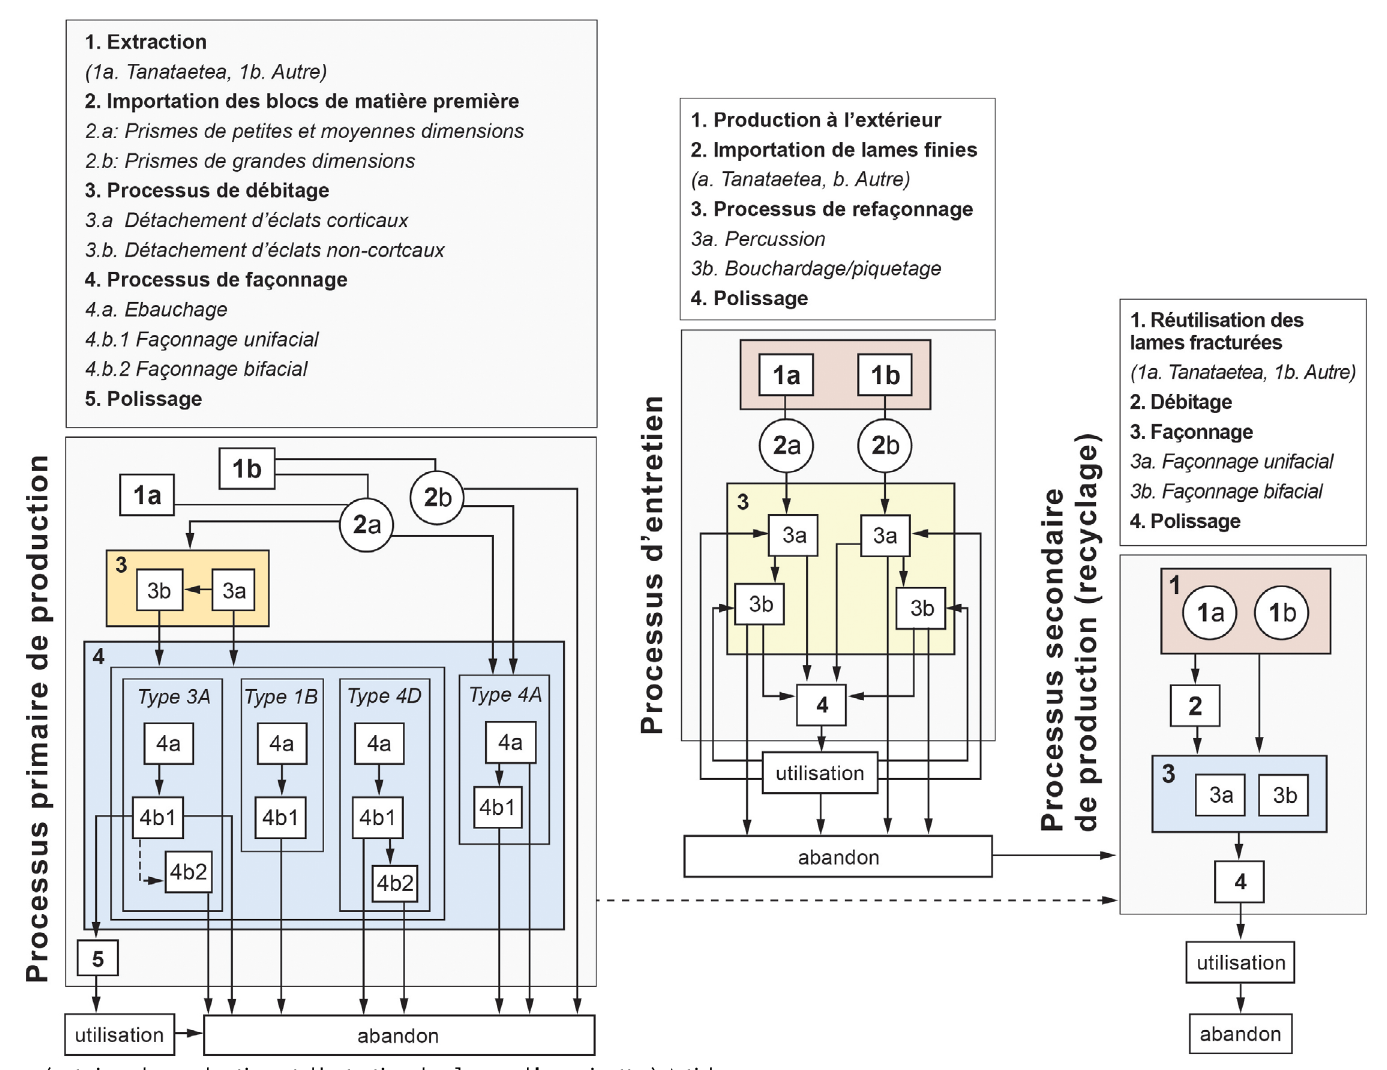
Figure 19. Chaînes opératoires de production et d'entretien des lames d'herminette à Atiahara. Figure 19. Production and maintenance processes of stone adze blades at